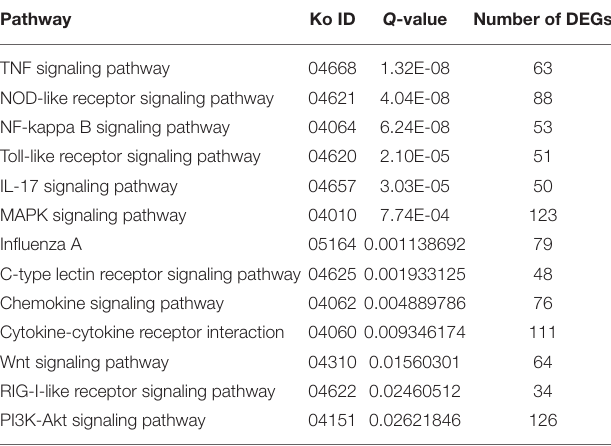
TABLE 3 | Association between the immune and signal transduction pathway in the lung transcriptome of rabbits infected with P. multocida type A at 3 dpi. Pathway Ko ID Q -value Number of